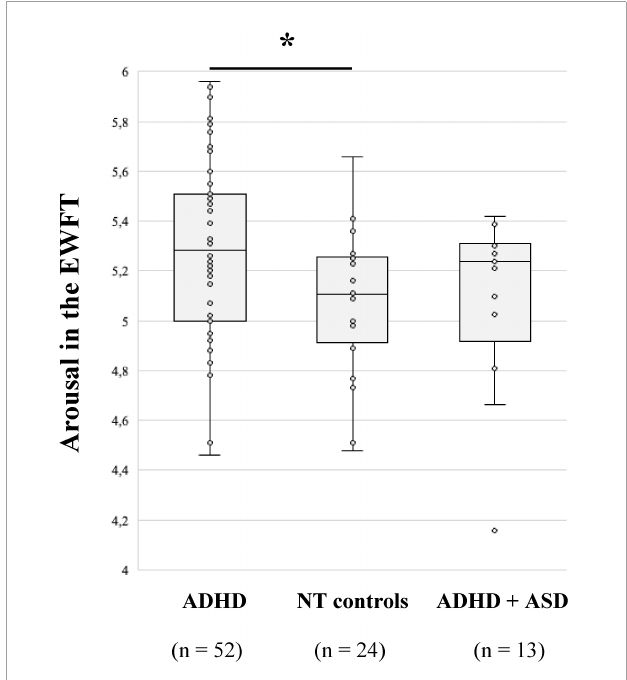
FIGURE1 Median arousal of emotions produced in the emotion word fluency test (EWFT) according to diagnostic groups. * p = 0.033, after the false discovery rate (FDR) correction, p =